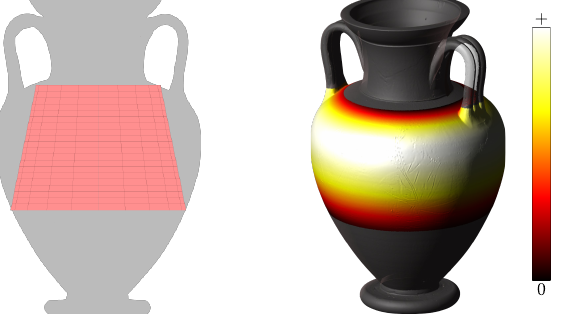
Figure 3: Heat map visualization of the distance to a fitted cone. Due to the high curvature of the vessel (KHM Inv.-No. 3601) larger distances at the middle part of the frustum are